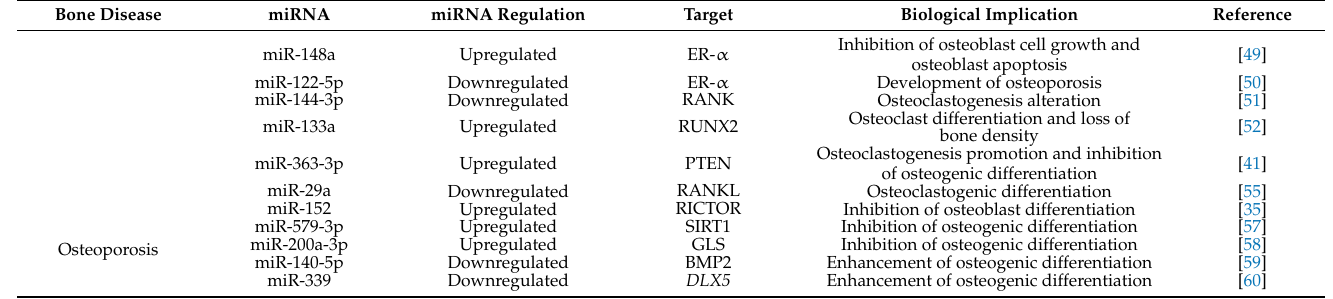
Table 1. Functional implications of miRNAs in the development and progression of bone diseases. Bone